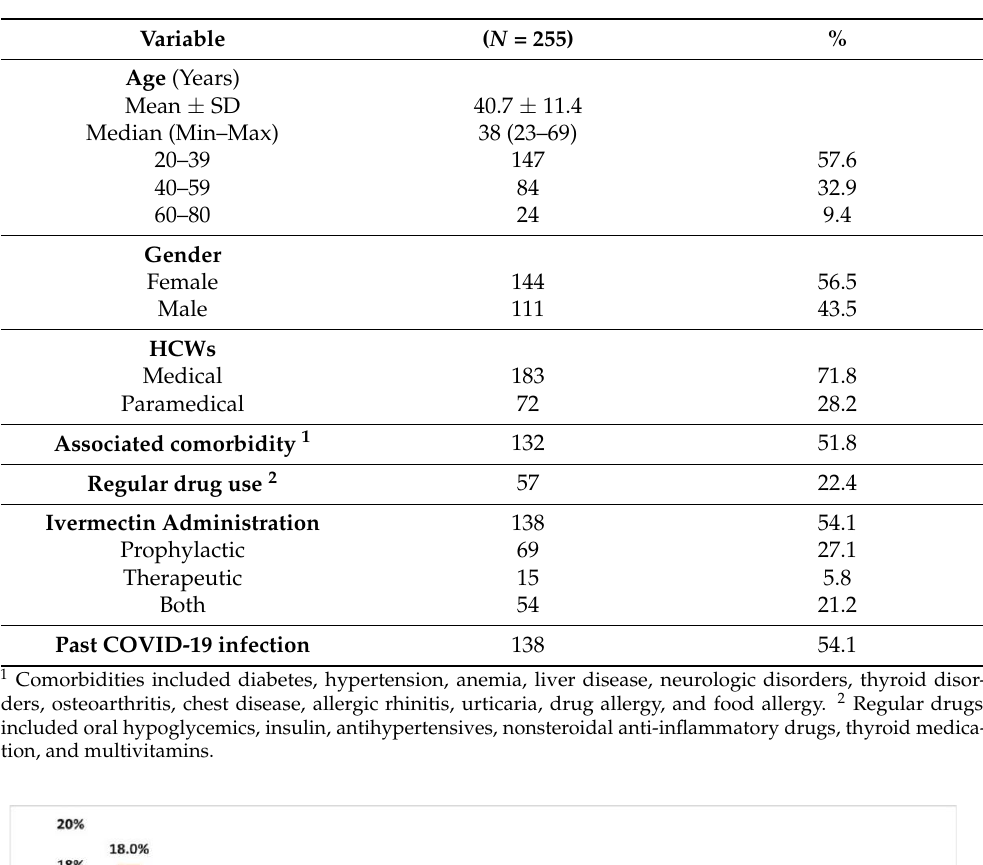
Table 1. Baseline characteristics of the studied patients.